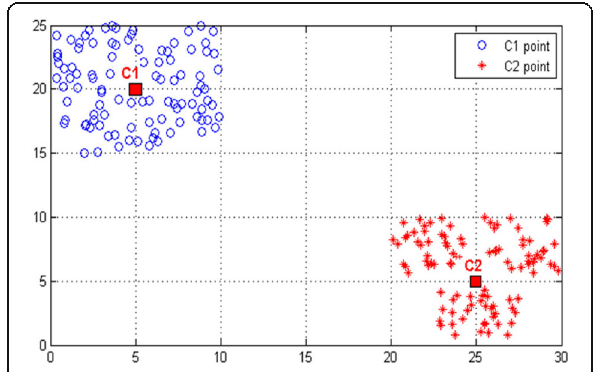
Fig. 2 Two clusters that share the same residuals but possess different spatial distribution